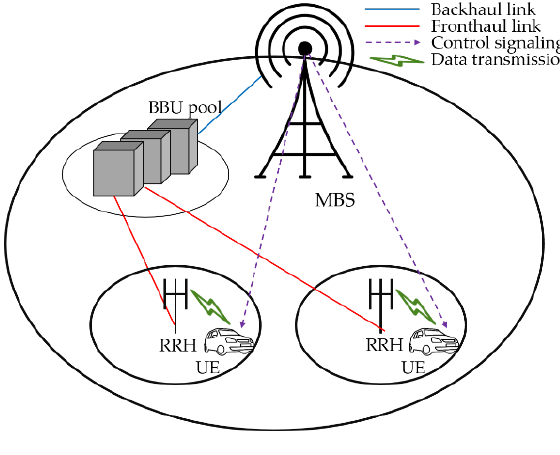
Figure 1. Architecture of H-CRAN.